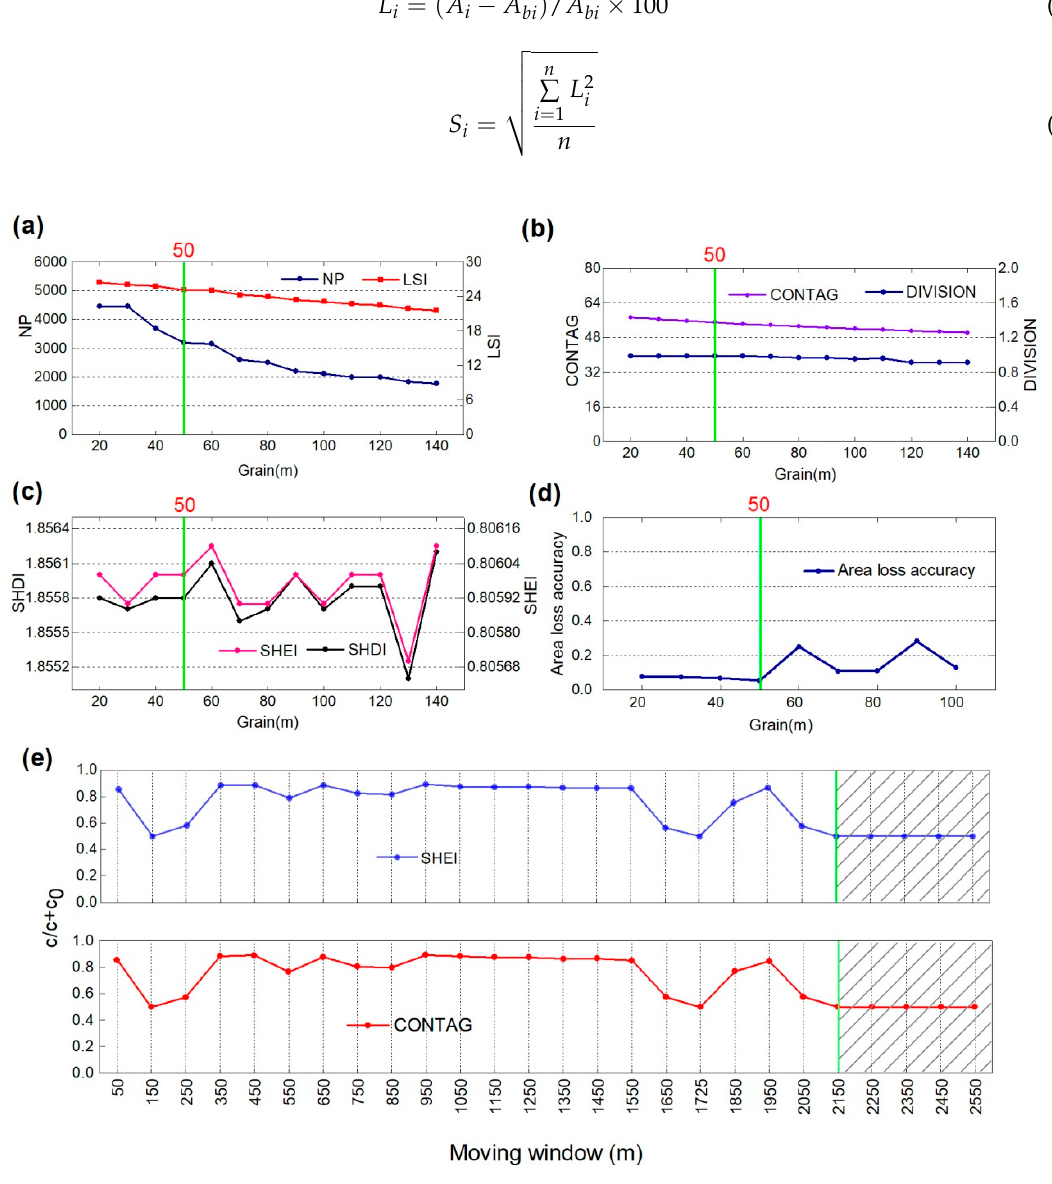
Figure 3. Changes of landscape metric values with grain ( a – c ) and changes in area landscape accuracy with different grain ( d ). With the increase in grain size, due to the boundary of the vector data and the changes of the properties of adjacent patches, scale turning points appear in the values of landscape metrics. Considering the distribution of inflection points and the calculation efficiency ( a – c ), 20–100 m was selected as the appropriate scale domain to determine the analysis grain for the next step ( d ). The block ratio of different moving windows is obtained ( e ).